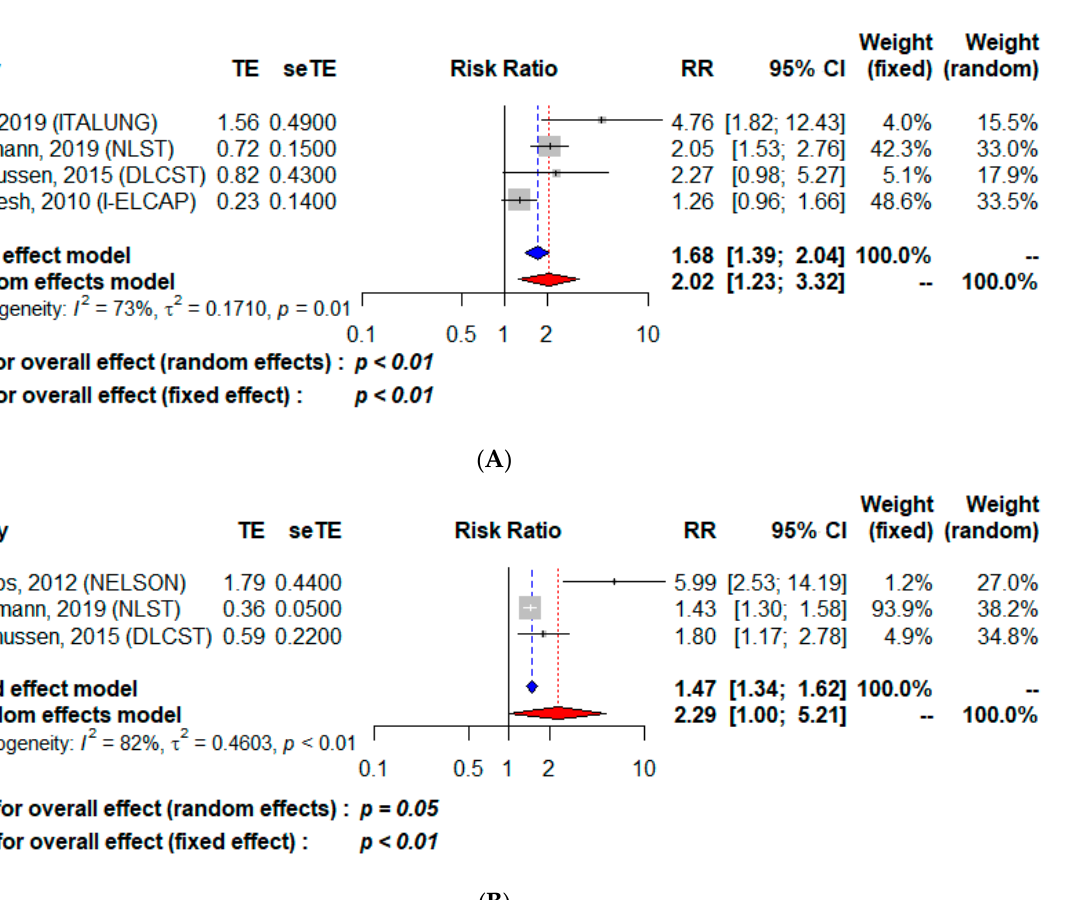
Figure 2. Cardiovascular ( A ) and all-cause ( B ) mortality according to the presence of coronary artery calcifications. TE, estimate of treatment effect, e.g., log hazard ratio or risk difference; seTE, Standard error of treatment estimate; RR, relative risk.